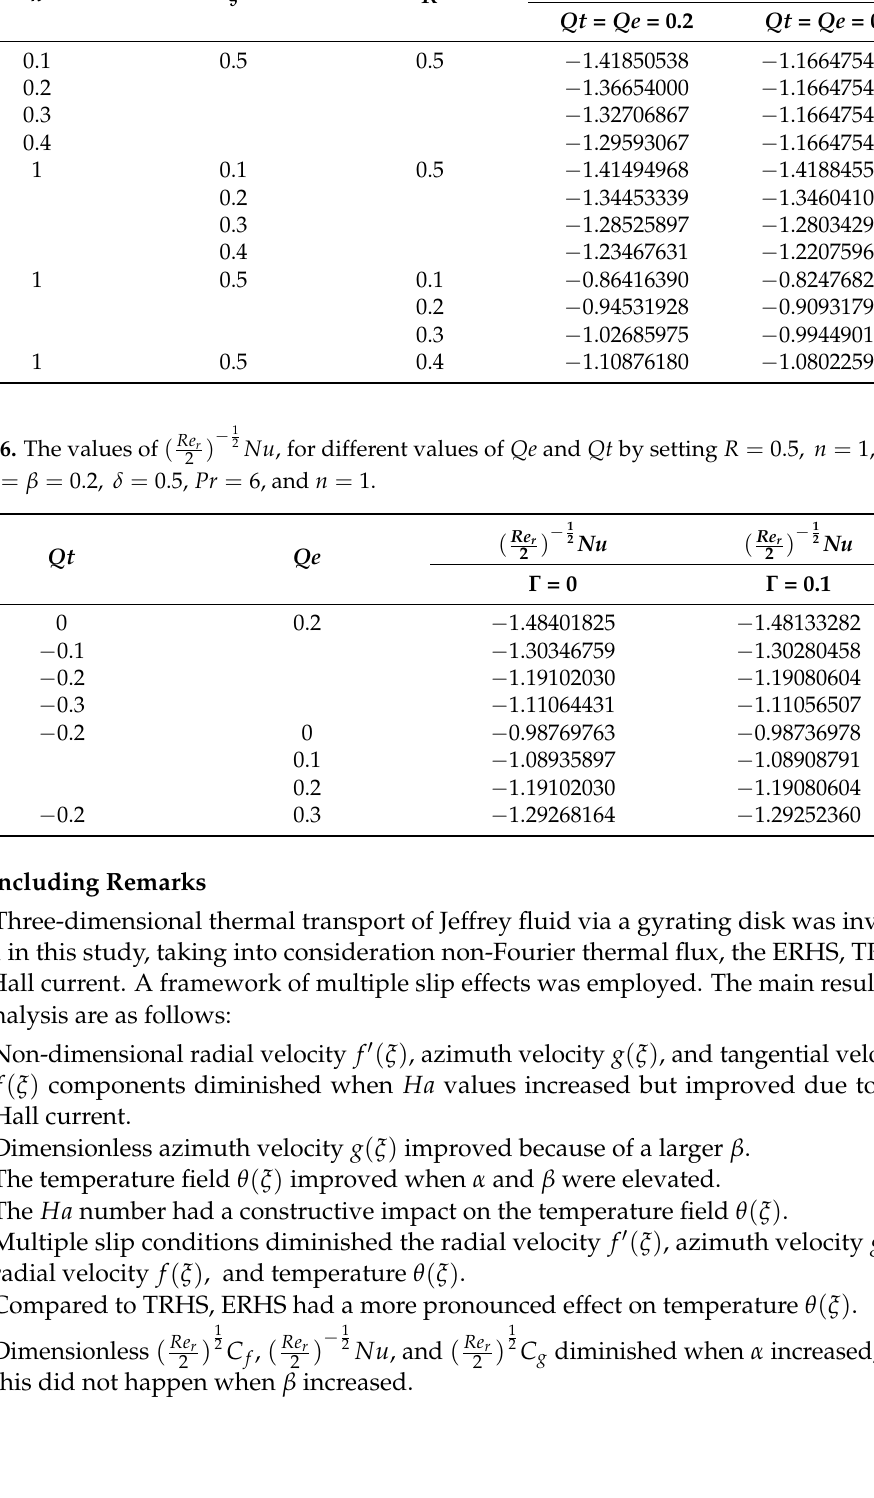
Table 5. The values of ( Re r Γ = 0.1, Pr = 6, and n = 1.